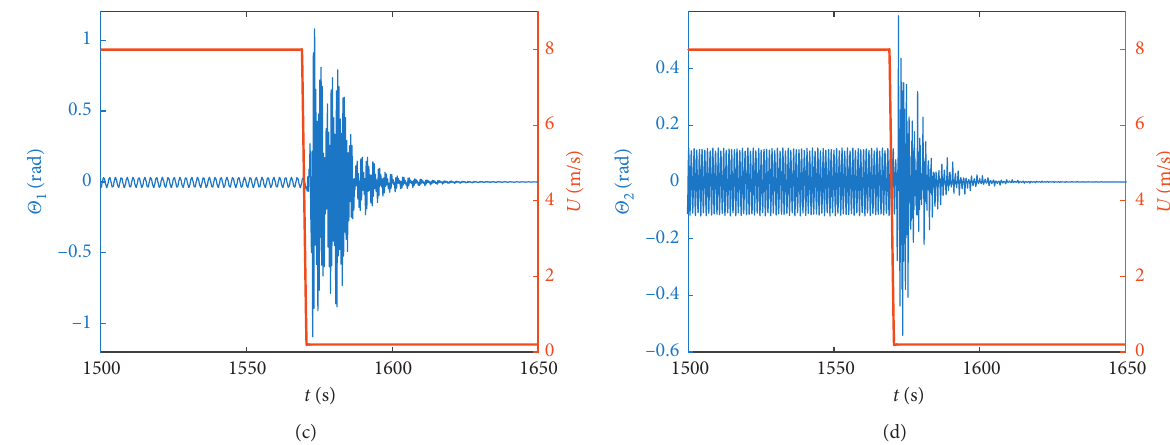
Figure 4: Time histories (1500–1650s). (a) 1 st in-plane mode. (b) 2 nd in-plane mode. (c) 1 st torsional mode. (d) 2 nd torsional mode.